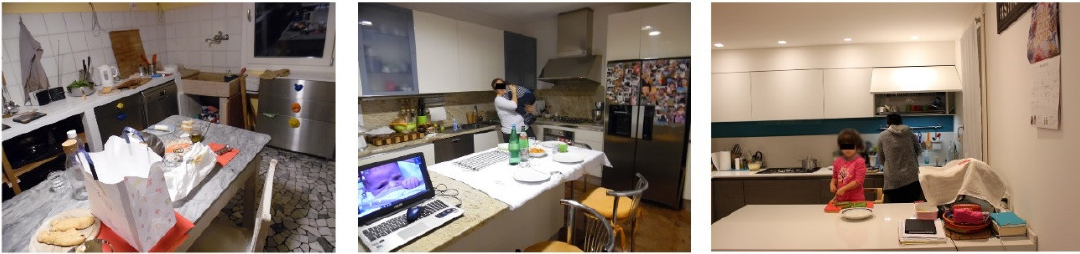
Figure 3. Objects unrelated to food handling.